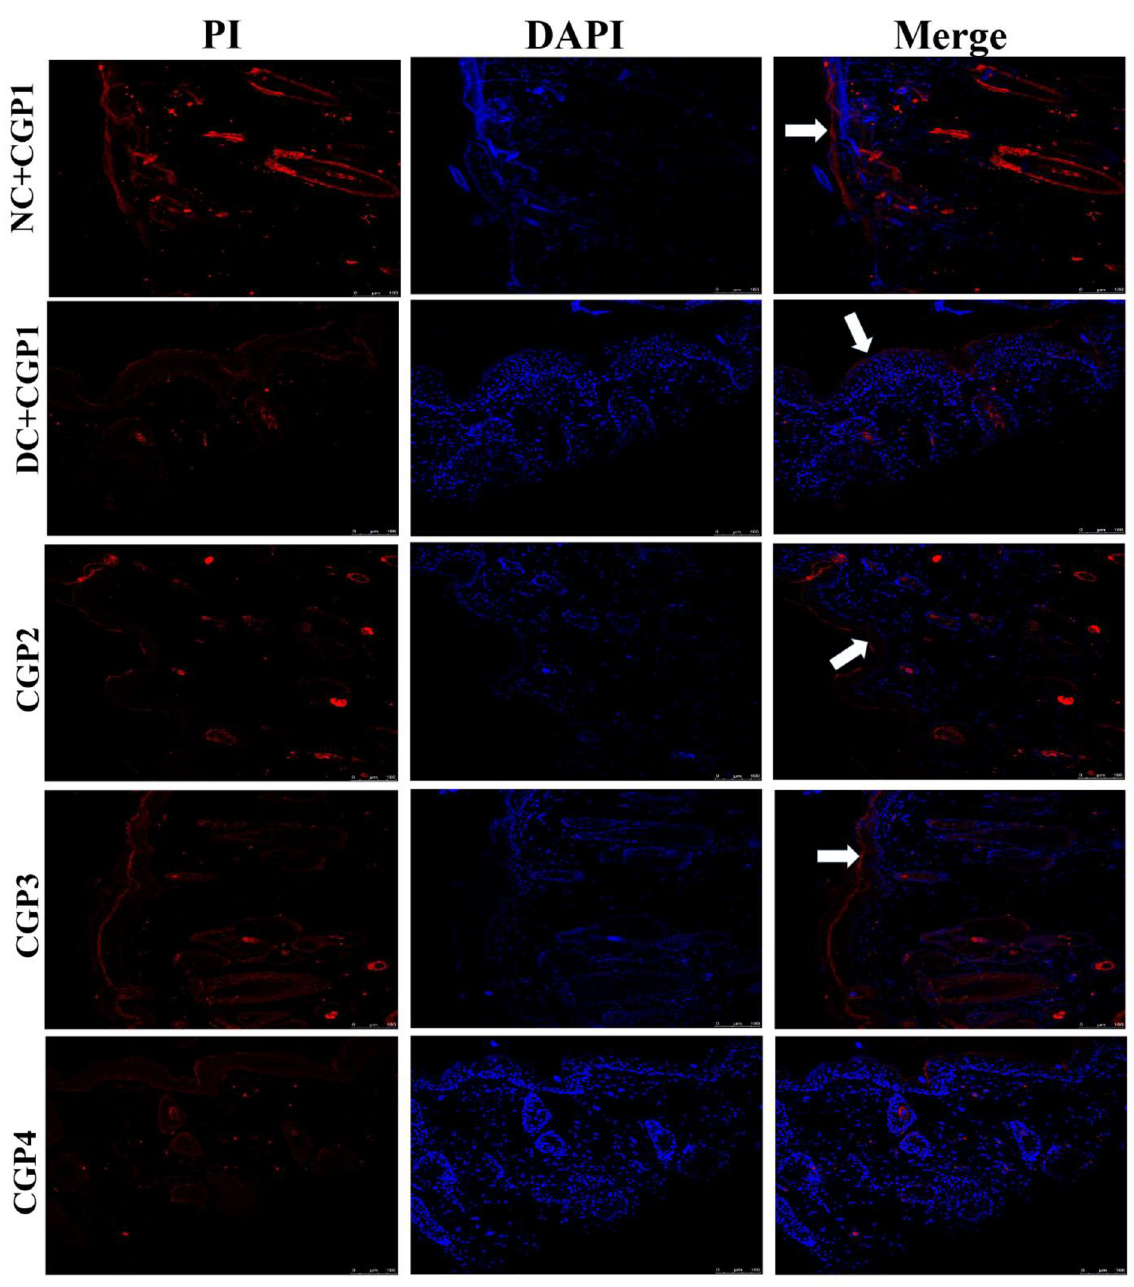
Fig 10. Effect of GC-AgNP CGPs dressing on BCL-2 in diabetic rats. Immunofluorescence images showing localization of BCL-2 (red). White arrows point towards the distribution of BCL-2 protein in red color. NC+CGP1: Normal control dressed with blank cotton gauze; DC +CGP1: Diabetic control rats dressed with blank cotton gauze; CGP2: Diabetic rats dressed with 13.06 μ M gallocatechin and silver nanoparticle (GC-AgNP) impregnated cotton gauze patches (DC+ 13.06 μ M CGP2); CGP3: Diabetic rats dressed with 26.12 μ M gallocatechin and silver nanoparticle (GC-AgNP) impregnated cotton gauze patches (DC+ 26.12 μ M CGP3). CGP4: Diabetic rats dressed with silver sulfadiazine (DC +AgS) impregnated cotton gauze patches. Data were expressed as mean ± S.E.M (n = 6). Scale bar = 100 μ m. may have impaired the diabetic rat ability to proliferate. Generally, GSK3 β is considered to be a Wnt signalling inhibitor [30]. GSK3 β activation results in β -catenin degradation, which decreases β -catenin expression. c-fos is a gene that promotes cell proliferation and